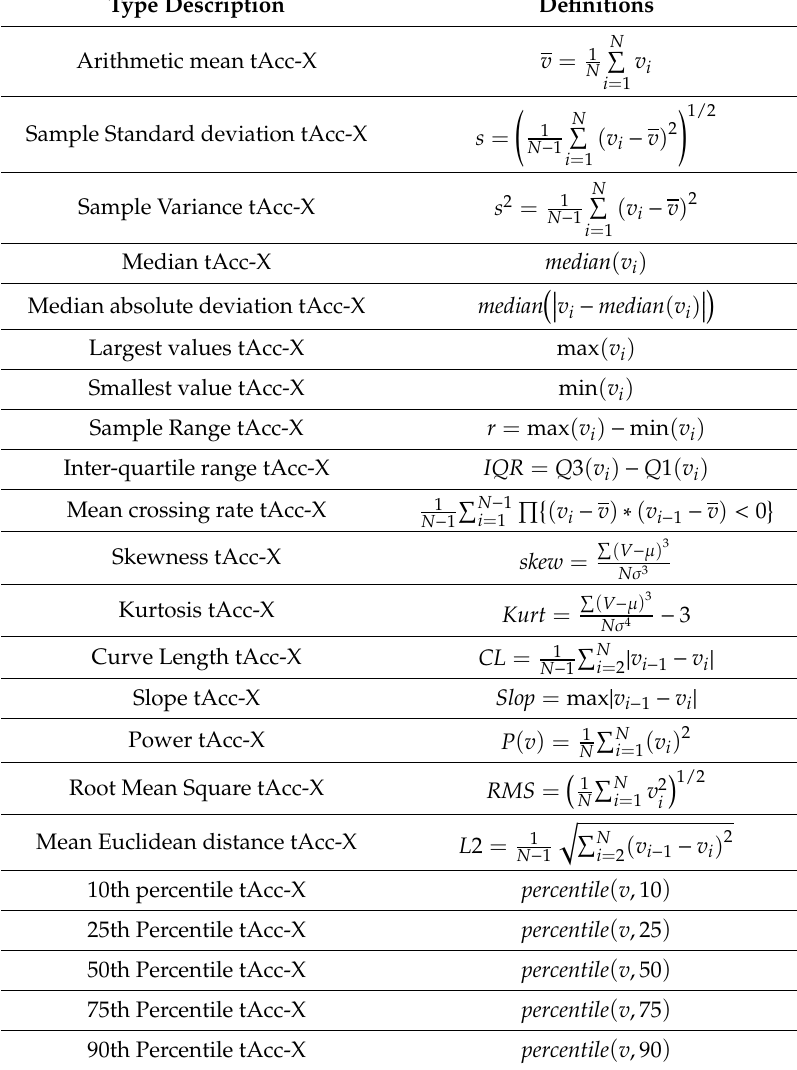
Table 1. Time domain features of the x -axis.